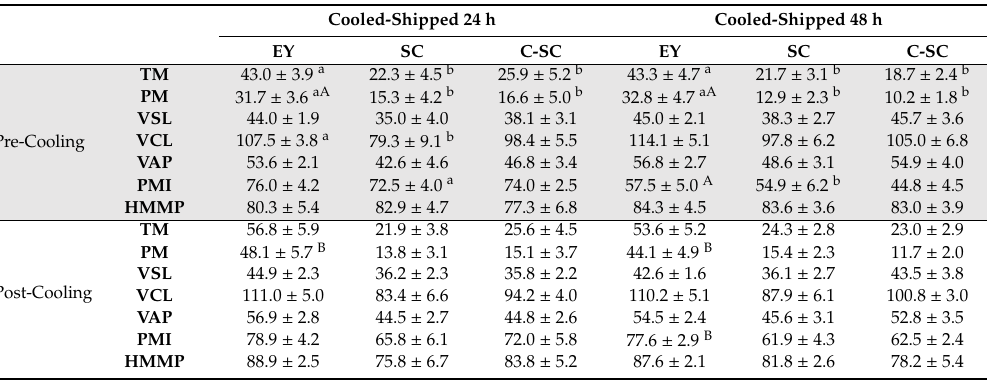
Motility and viability parameters of the donkey epididymal semen harvested from cooled-shipped epididymides dissected away from the testes. The epididymides were processed upon arrival ( n = 20 pairs, cooled-shipped 24 h ) or the following day post-arrival ( n = 16 pairs, cooled-shipped 48 h ). All epididymides were kept in the passive cooling device until processing. For each of the time points, each epididymal pair was submitted to retrograde flushing with a freezing egg yolk-based extender ( EY ), or a cooling extender based on sodium caseinate cholesterol-loaded cyclodextrin ( SC ). Thereafter, the semen extended in EY was cooled for 24 h; whereas the semen extended in SC was cooled for 24 h, or cushion-centrifuged, re-extended with SC, and then cooled for 24 h ( C-SC ). Semen was assessed immediately after harvesting ( pre-cooling ) and after cooling for 24 h ( post-cooling ). Data are expressed as the mean ±